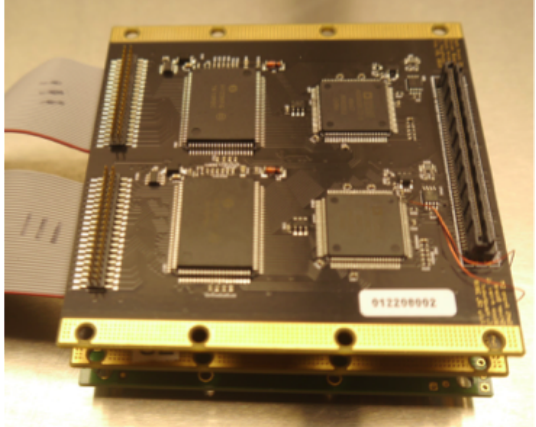
Figure 5. Miniaturized DM driver electronics for DeMi CubeSat payload as described in [20]. The dimensions of each board are 80 mm × 80 mm × 10 mm. The complete driver stack consists of two driver boards, the high voltage power supply board, and the two Raspberry Pi boards. Each driver board has 70 output channels with 14 bits of resolution from 0 to 180